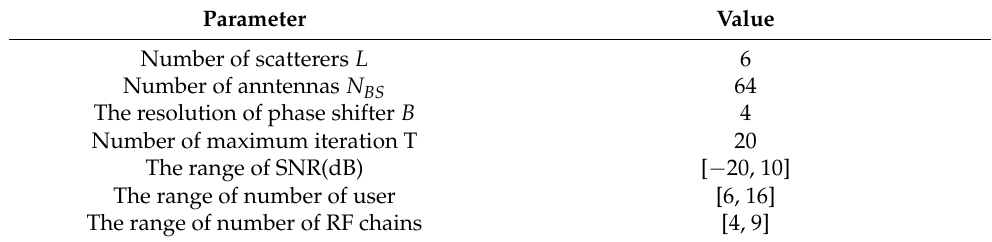
Table 1. Simulation Setup and